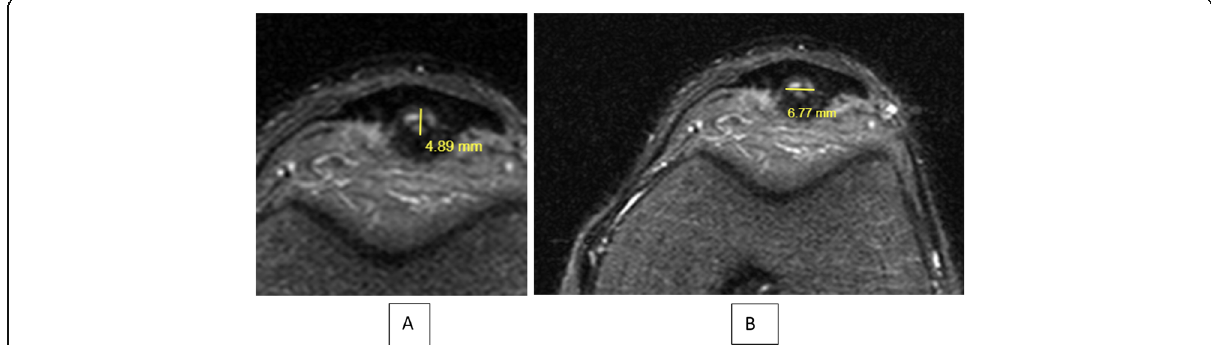
Fig. 2 A MRI evaluation: Thickness of the tear. B Width of the